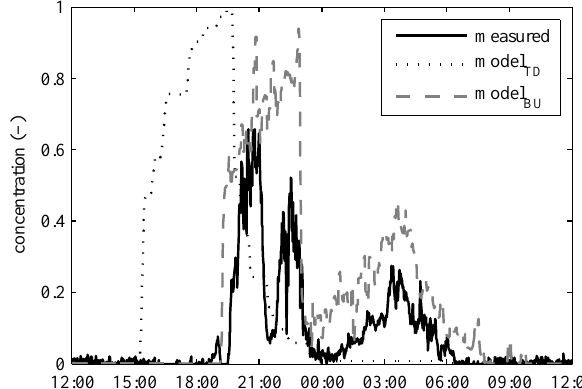
Figure 8. Measured and modelled pulses at measurement loca- tion 3 at 14–15 October